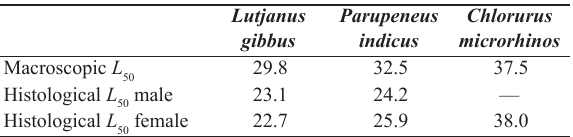
Table 3. A comparison of macroscopic (from Prince et al. 2019) and histology-based (present report) estimates of L for three reef fishes from